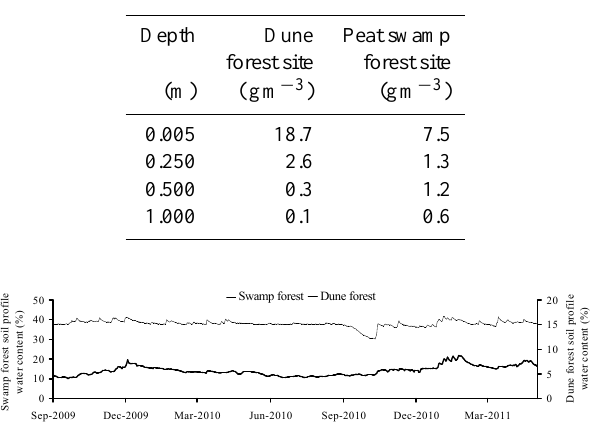
Table 3. Dry root mass per unit volume of soil along a 1.0m soil profile at the peat swamp forest and dune forest sites.